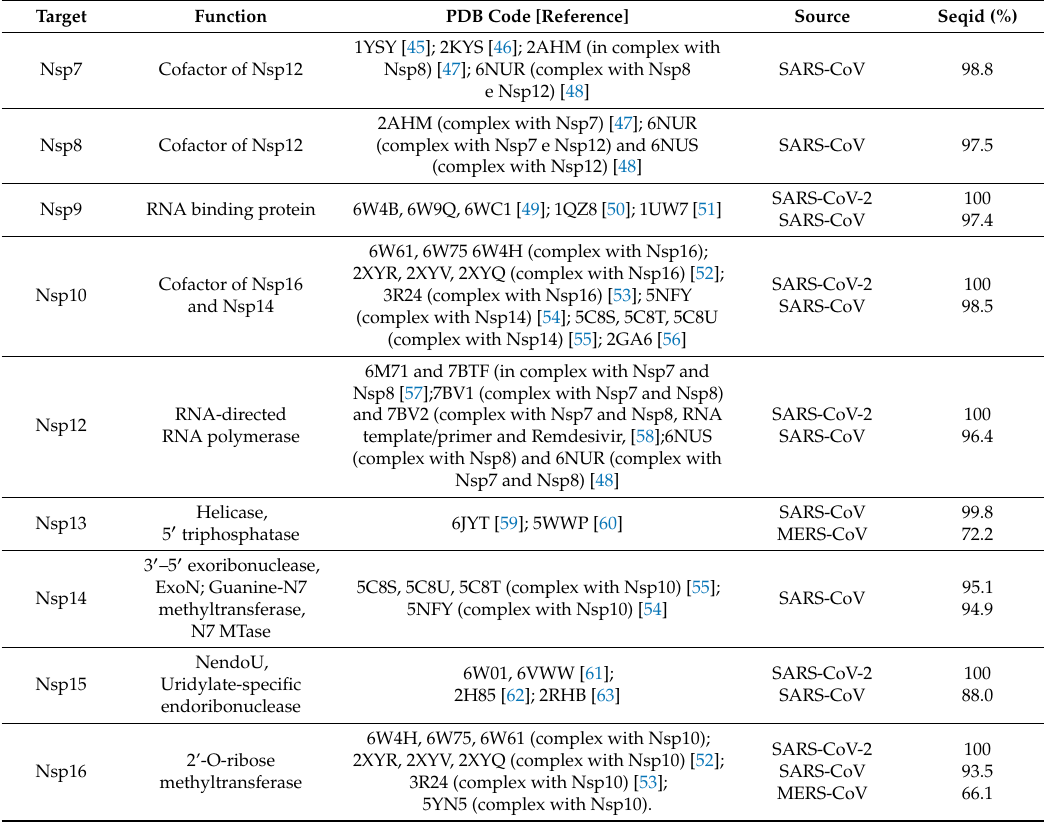
Table 1. Available structural information on putative SARS-CoV-2 RNA replication machinery